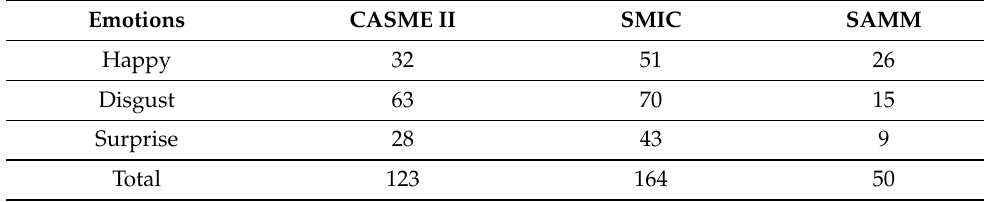
Table 1. Experimental datasets with their class